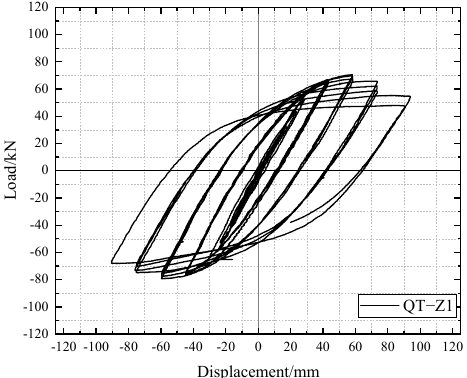
Figure 14. Load-lateral hysteresis curve of QT − Z1.